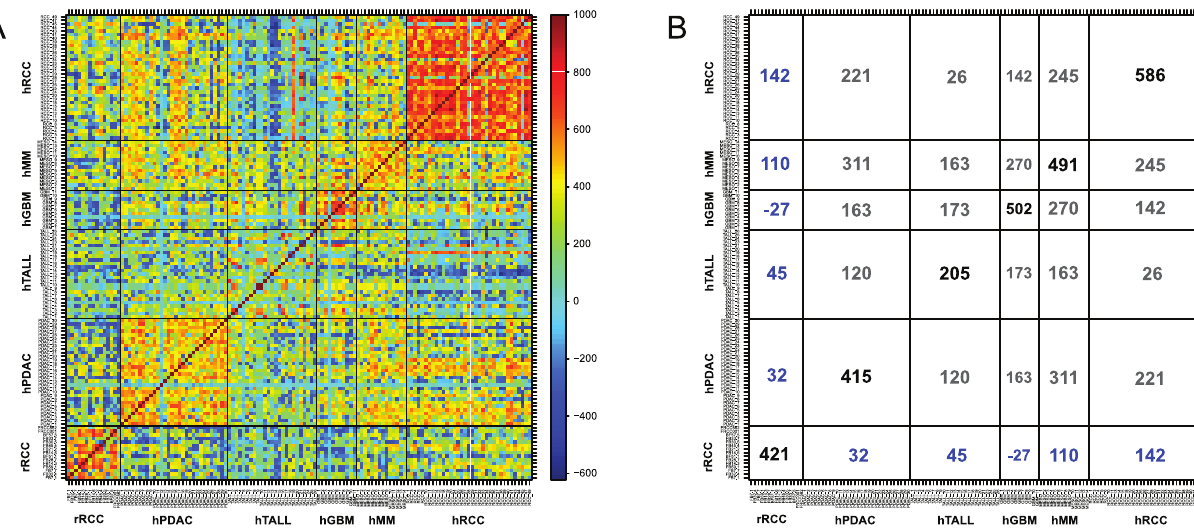
Figure 5. Comparison of copy number alteration profiles in cancer genomes between Fe-NTA-induced rat RCCs and human tumors. (A) The color plot represents a similarity matrix across the rat RCCs and various human cancers. rRCC, rat renal cell carcinoma; hPDAC, human pancreatic ductal adenocarcinoma; hTALL, human T-cell acute lymphoblastic leukemia; hGBM, human glioblastoma multiforme; hRCC, human renal cell carcinoma. (B) Numerical summary of the similarity matrix. The number in each square indicates an average value of similarity index (defined between 2 1000 and 1,000). Refer to the Materials and Methods section for details.